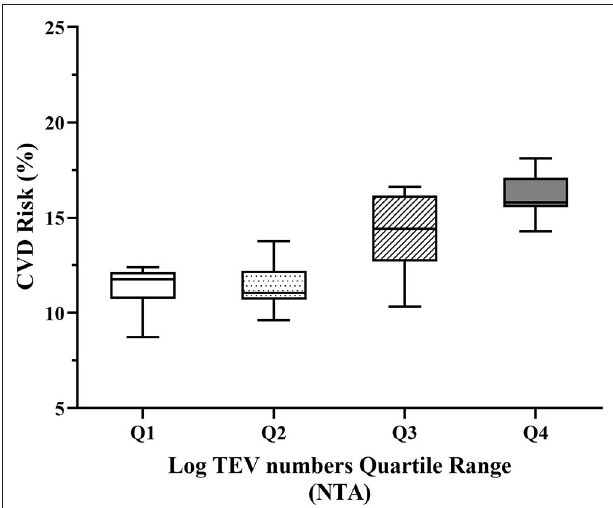
FIGURE 3 | Adjusted 10-year CVD risk relative to quartiles of circulating EV numbers. Increasing quartiles of TEV numbers were associated with increased 10-year CVD risk adjusted for age, plasma TAG and HDL-C ( p < 0.001). TEVs, TAG and HDL-C were log-transformed to achieve normal distribution before analysis. CVD, cardiovascular diseases; HDL-C, high-density lipoprotein cholesterol; NTA, nanoparticle tracking analysis; TAG, triacylglycerol; TEVs, total extracellular